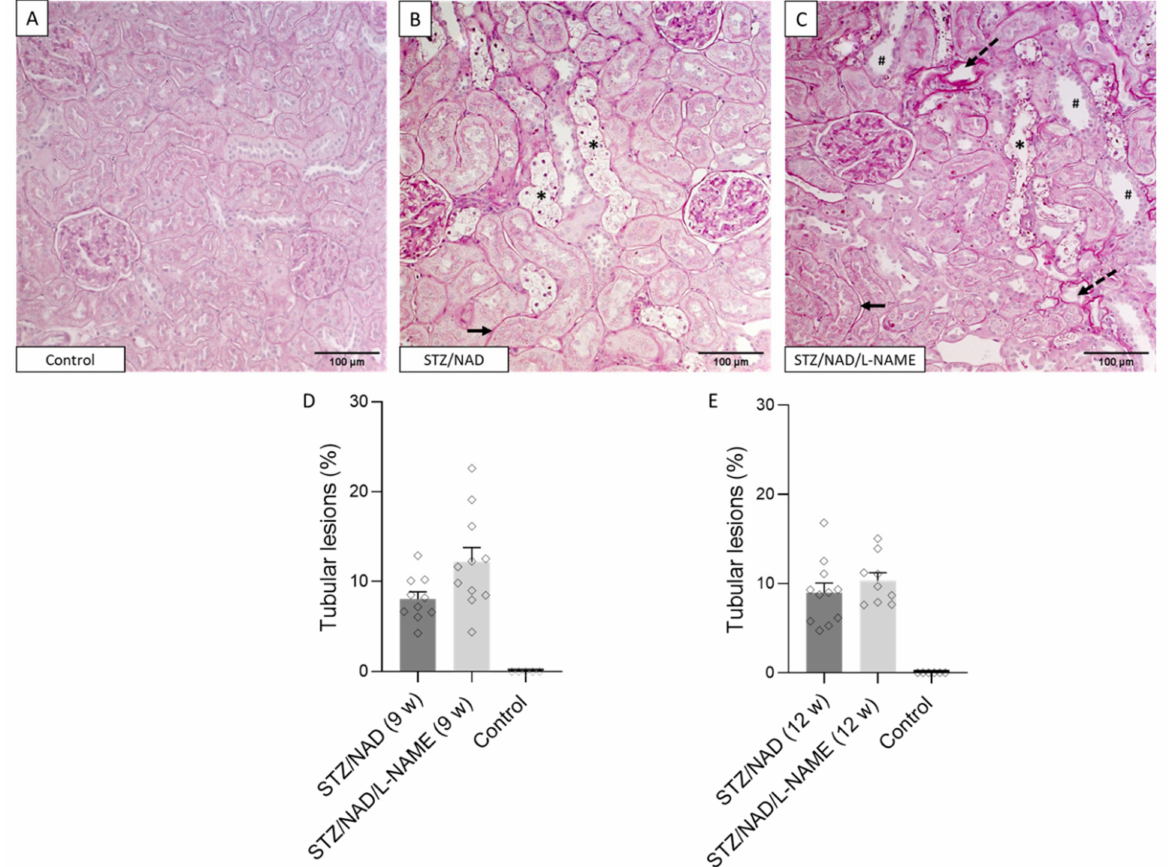
Figure 5. Histopathology staining of DKD. PAS-stained renal sections of a non-diabetic control rat ( A ), STZ/NAD ( B ) and STZ/NAD/L-NAME diabetic rat at week 12 ( C ). Tubular epithelial cell necrosis (asterisk), tubular atrophy (dashed arrow), thickening of tubular basement membrane (arrow), and tubular dilatation (#). Tubular lesions were quantified in control, STZ/NAD, and STZ/NAD/L-NAME rats after 9 weeks ( D ) and 12 weeks ( E